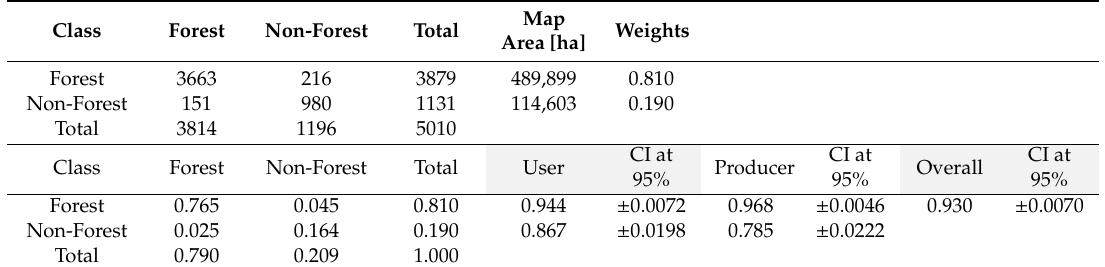
Table A1. Confusion matrix for 2016 FNF map of Peru (plots and area weights). Map categories are the rows, reference categories are the columns.